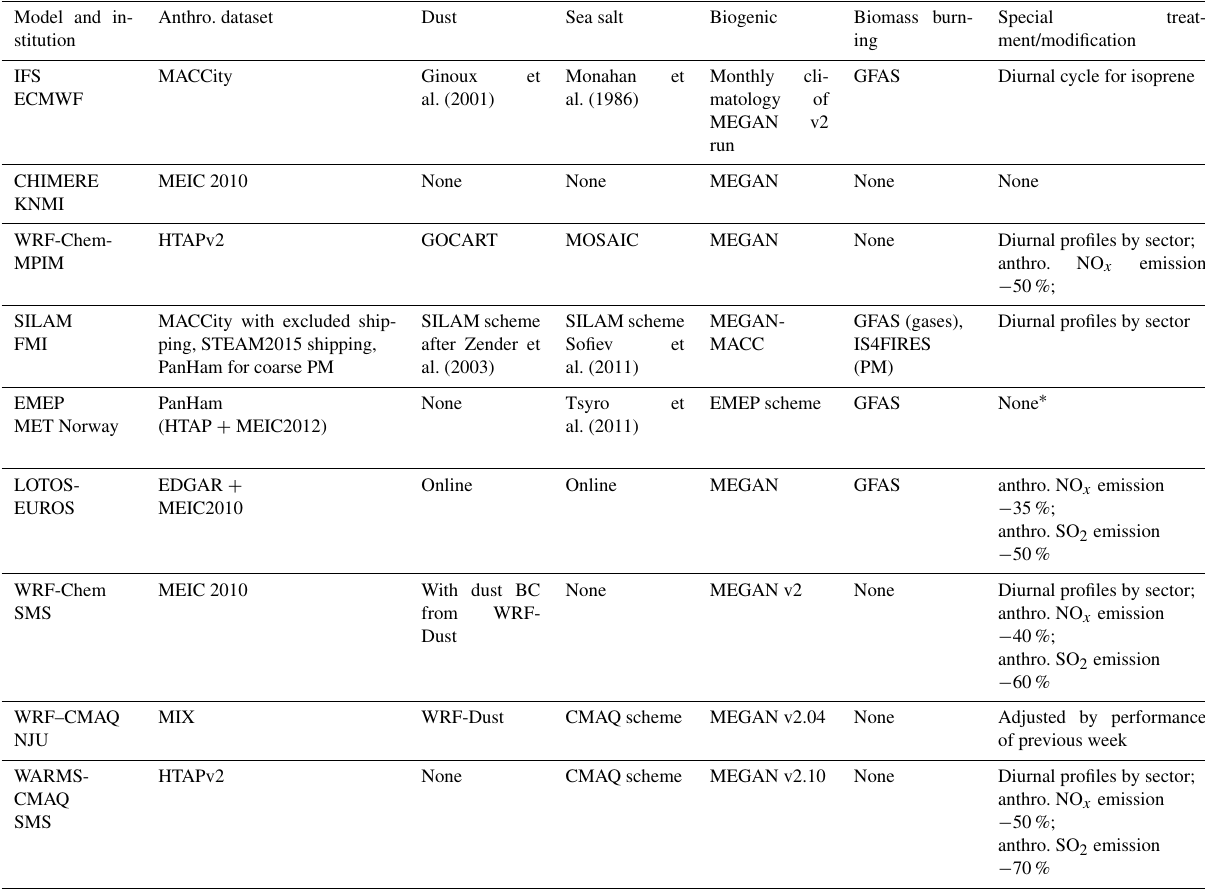
Table 3. Adopted